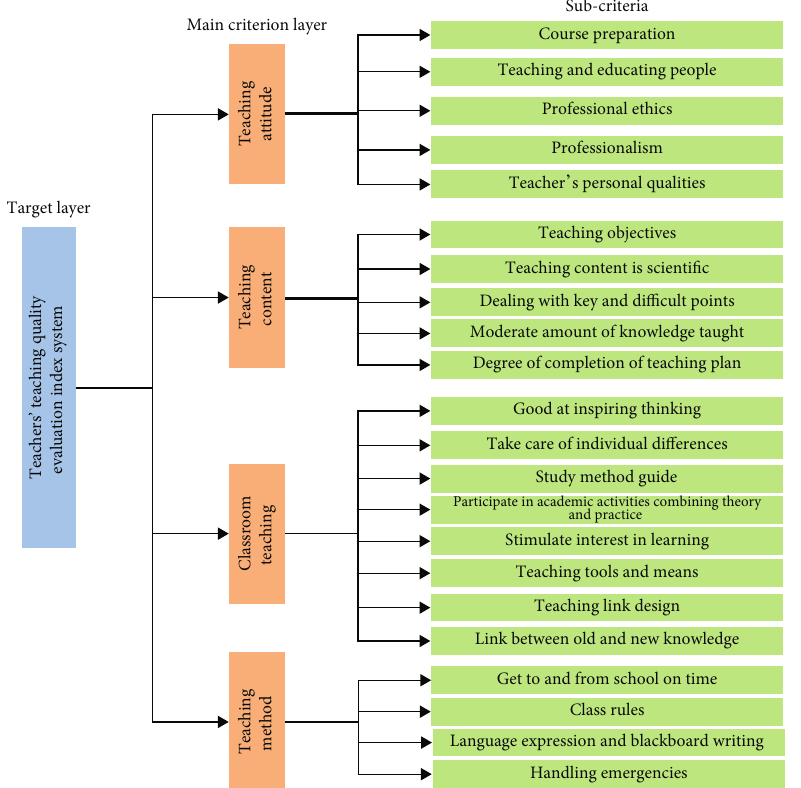
Figure 3: Teachers ’ teaching quality evaluation index system.